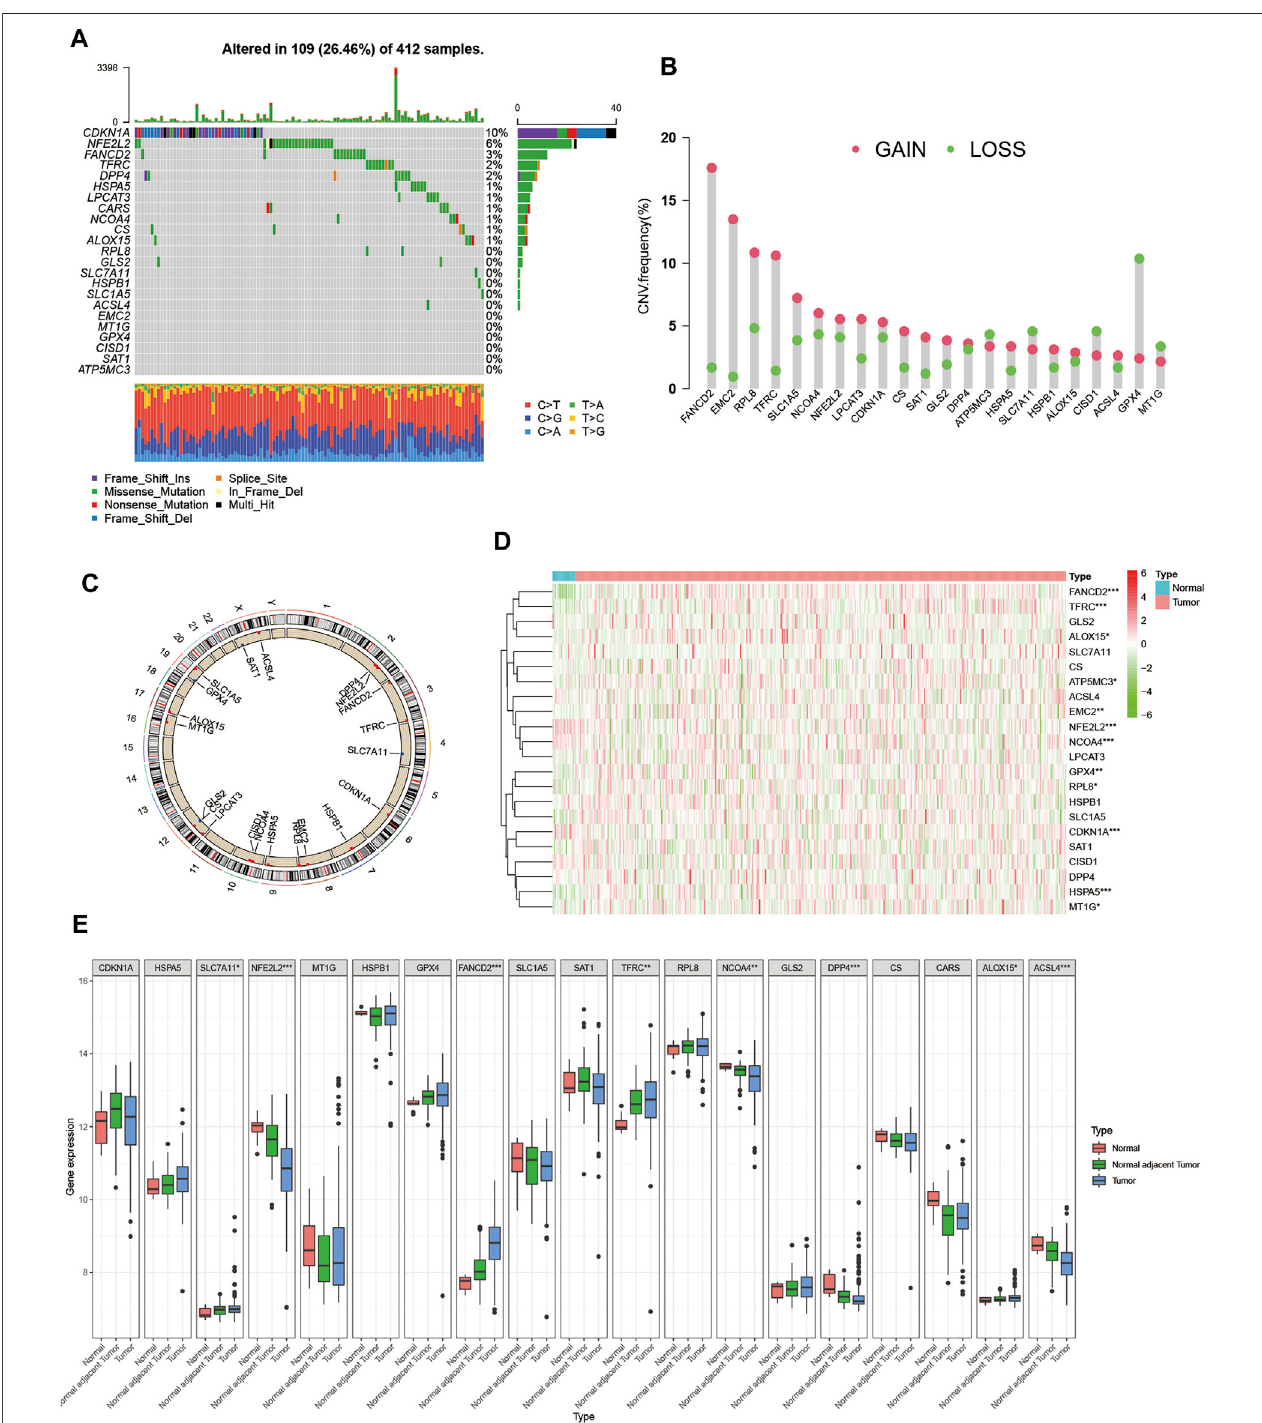
FIGURE1| LandscapeofgeneticandexpressionvariationofferroptosisregulatorsinBCa. (A) Mutationfrequencyof23ferroptosisregulatorgenesin412patients with BCa from the TCGA-BLCA cohort. Each column represented individual patients. The upper barplot showed TMB. The number on the right indicated the mutation frequency in each regulator gene. The right barplot showed the proportion of each variant type. The stacked barplot below showed a fraction of conversions in each sample. (B) CNV variation frequency of ferroptosis regulator genes in GSE13507 cohort. The height of the column represented the alteration frequency. The deletion frequency, green dot; The ampli fi cation frequency, red dot. (C) Location of CNV alteration of ferroptosis regulator genes on 23 chromosomes using GSE13507 cohort. (D) Expression of 22 ferroptosis regulator genes between normal bladder tissues and tumor tissues in the TCGA-BLCA cohort. Tumor, red; Normal, blue. Each